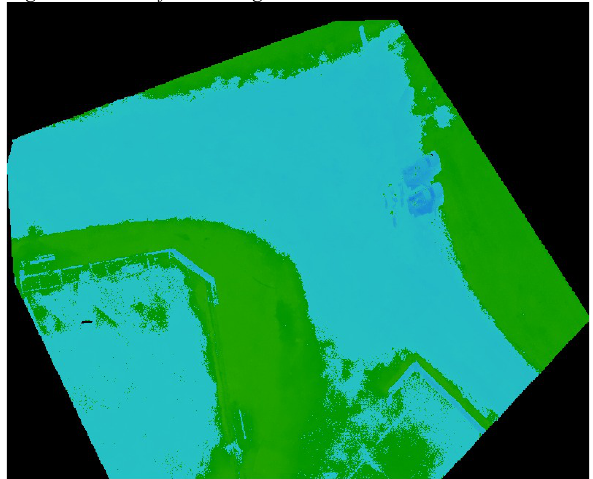
Figure 7. NDVI of